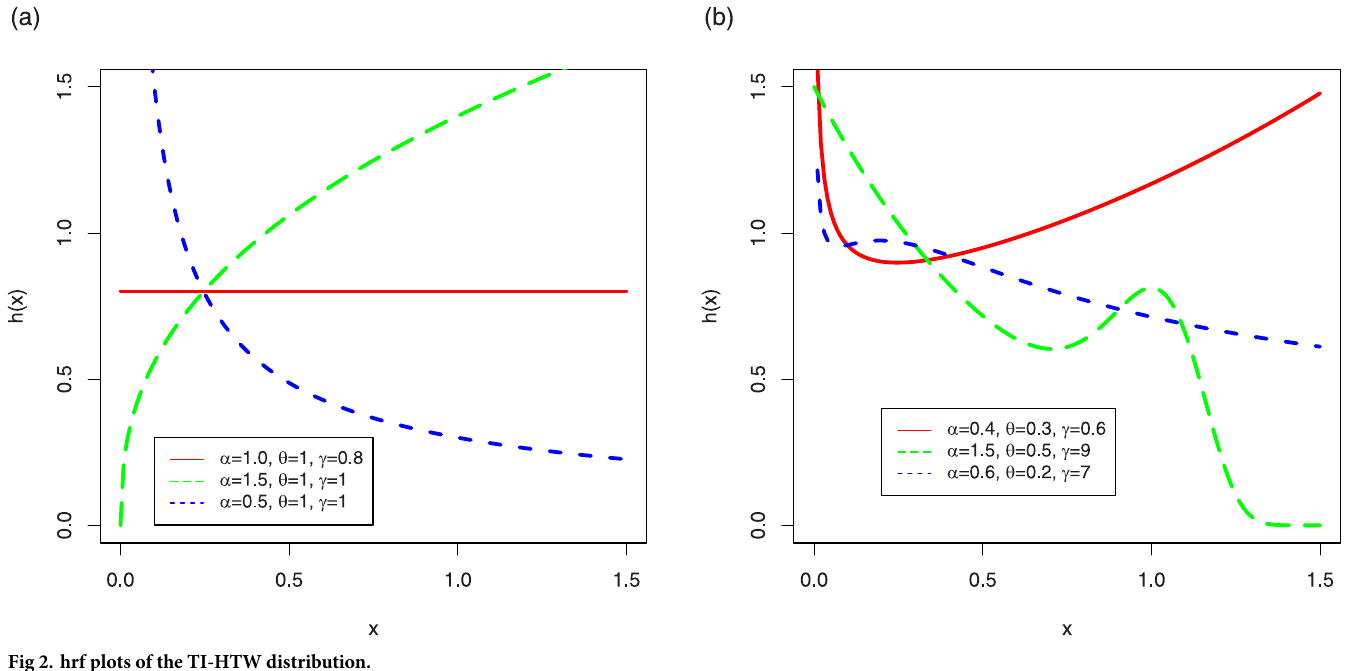
Fig 2. hrf plots of the TI-HTW